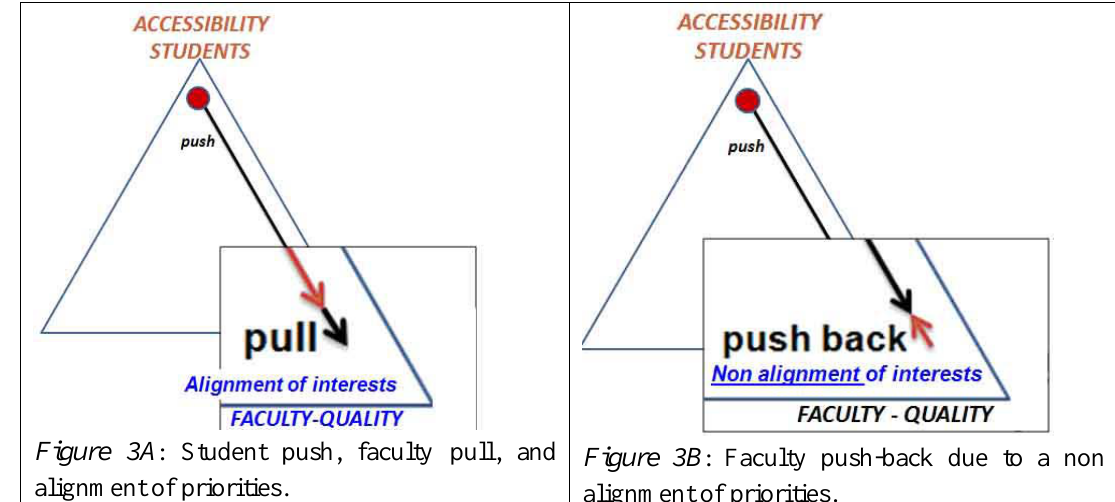
Figure 3B : Faculty push-back due to a non alignment of priorities.